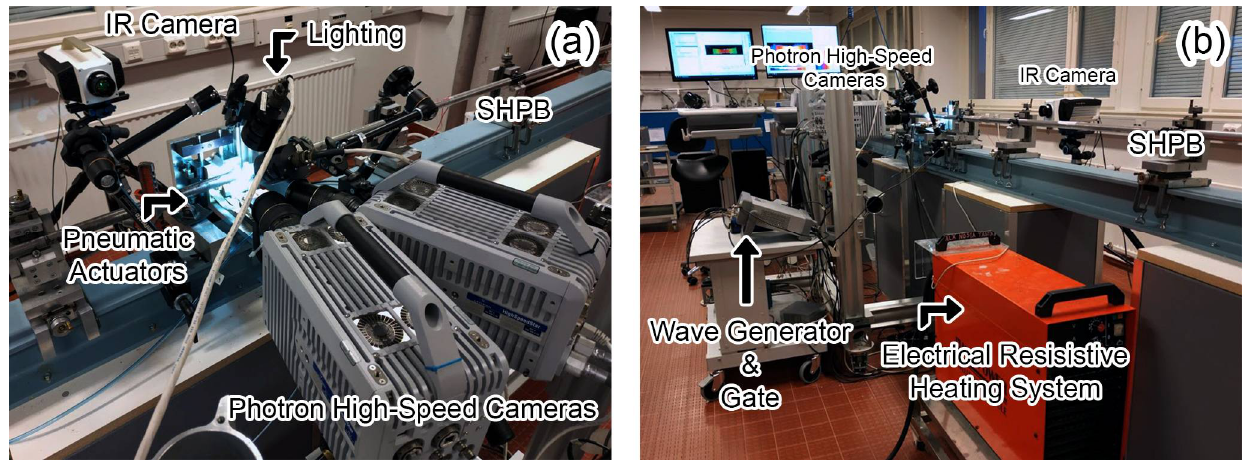
Figure 2. Experimental setup for the high-temperature and high-strain rate tensile tests. ( a ) Close-up showing the cameras, lighting, and pneumatic actuators for the heating system, and ( b ) general view also showing the electrical resistive heating system, the wave generator, and the analog gate.